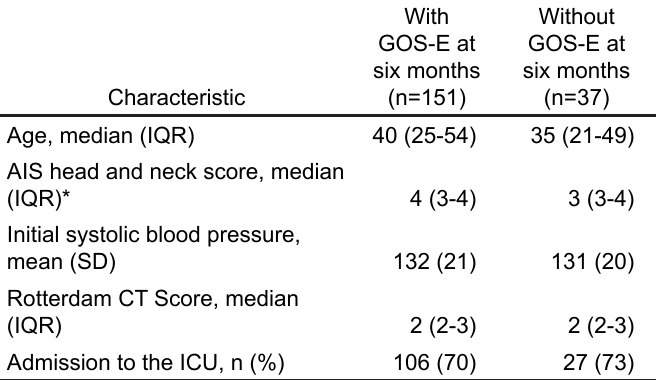
Table 2. Extended Glasgow Outcome Score (GOS-E) at 6 months. Table 3. Comparison of variables for patients with and without Extended Glasgow Outcome Score (GOS-E) at 6